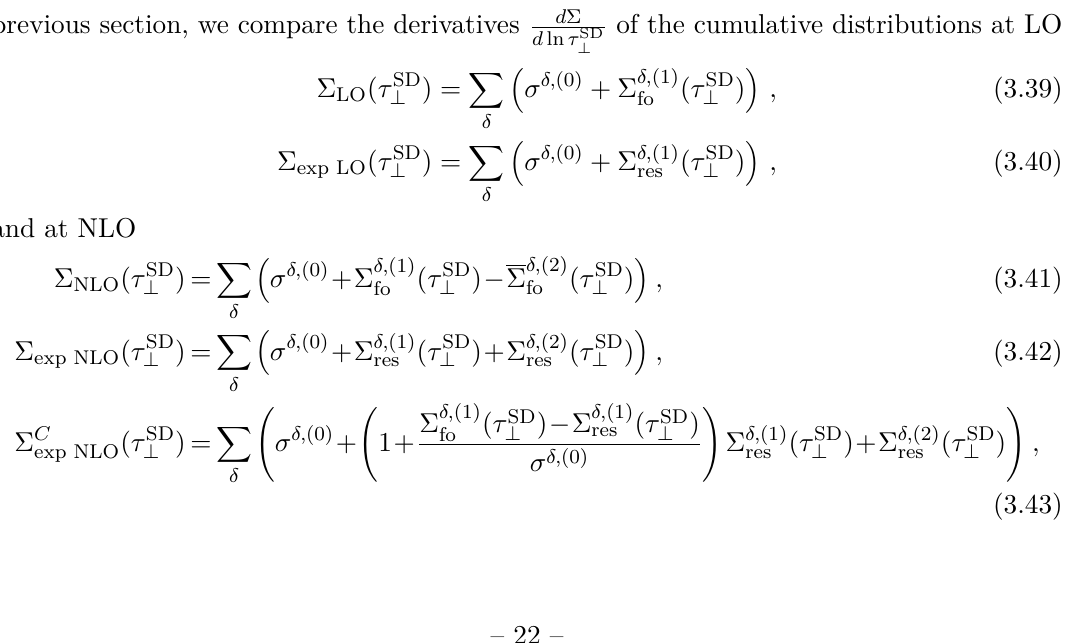
Figure 7 . Comparison of the expansion of the NLL resummation and fixed-order results for soft- drop groomed thrust at LO and NLO accuracy. The lower panels show the difference between expansion and fixed order at LO and